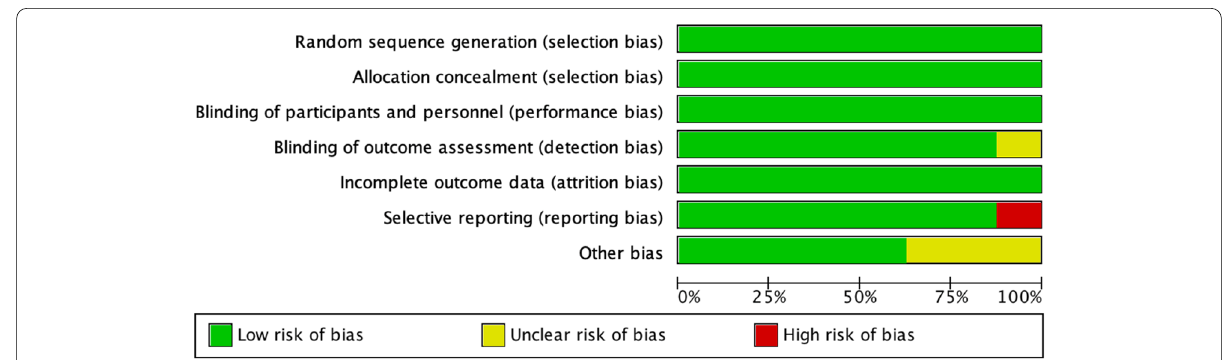
Fig. 2 Bias risk assessment using RoB 1